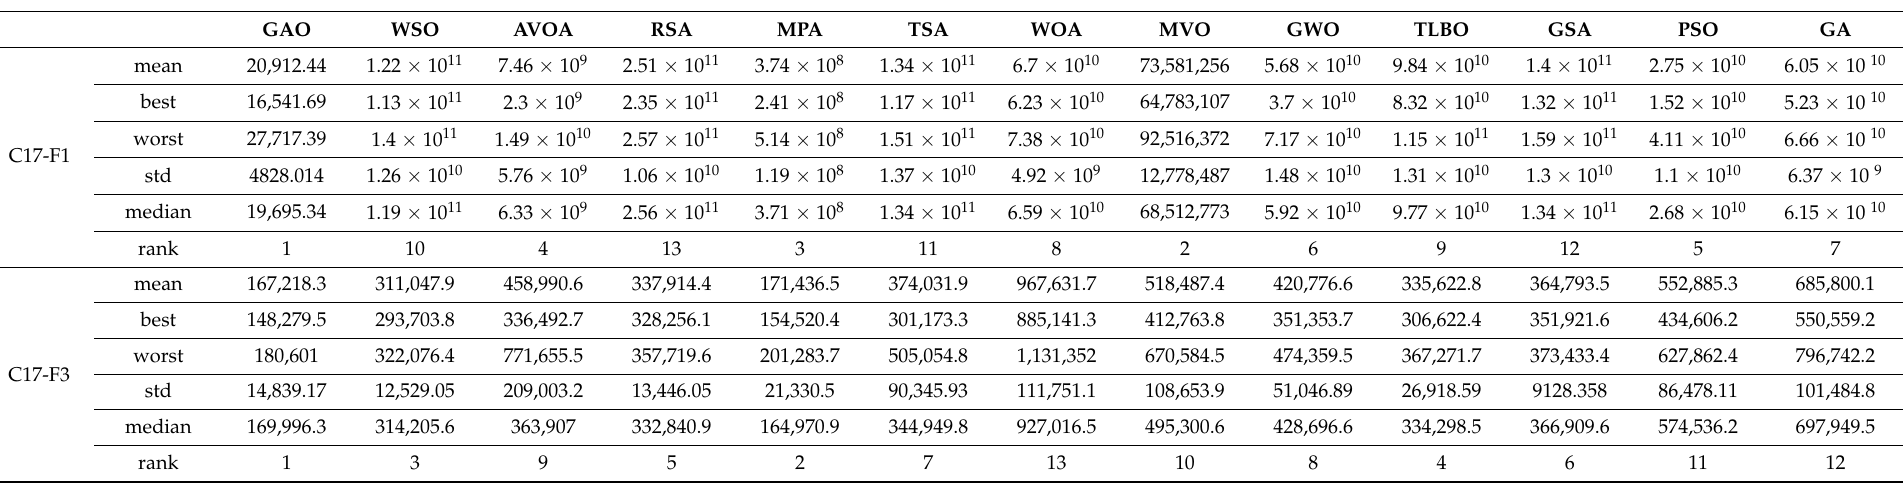
Table 5. Optimization results of the CEC 2017 test suite (dimension m =